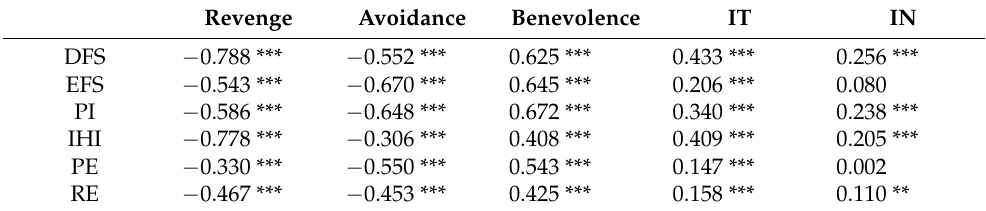
Table 3. Correlations between DFS and EFS, with TRIM-18 and SCS. Revenge Avoidance Benevolence IT